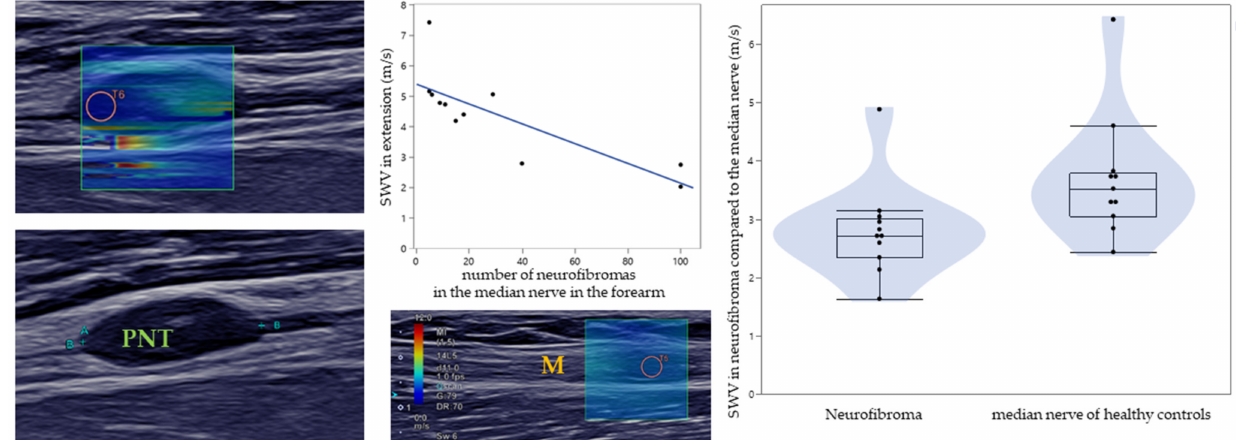
Figure 1. Measurement of a peripheral nerve tumor (PNT) in the median nerve. Left: Both B-mode images show the same PNT (above: with SWV, below: without SWV). Middle: Above, the diagram shows the distribution of SWV related to the number of PNTs. In blue, the correlation between the SWV in extension and the number of PNTs is shown. Below, a measurement of the SWV in the median nerve (M) is shown. Right: Boxplots comparing the SWV in neurofibroma with the SWV in the median nerve of healthy controls. The SWV is scaled from 0 m/s to 12 m/s by color (blue to